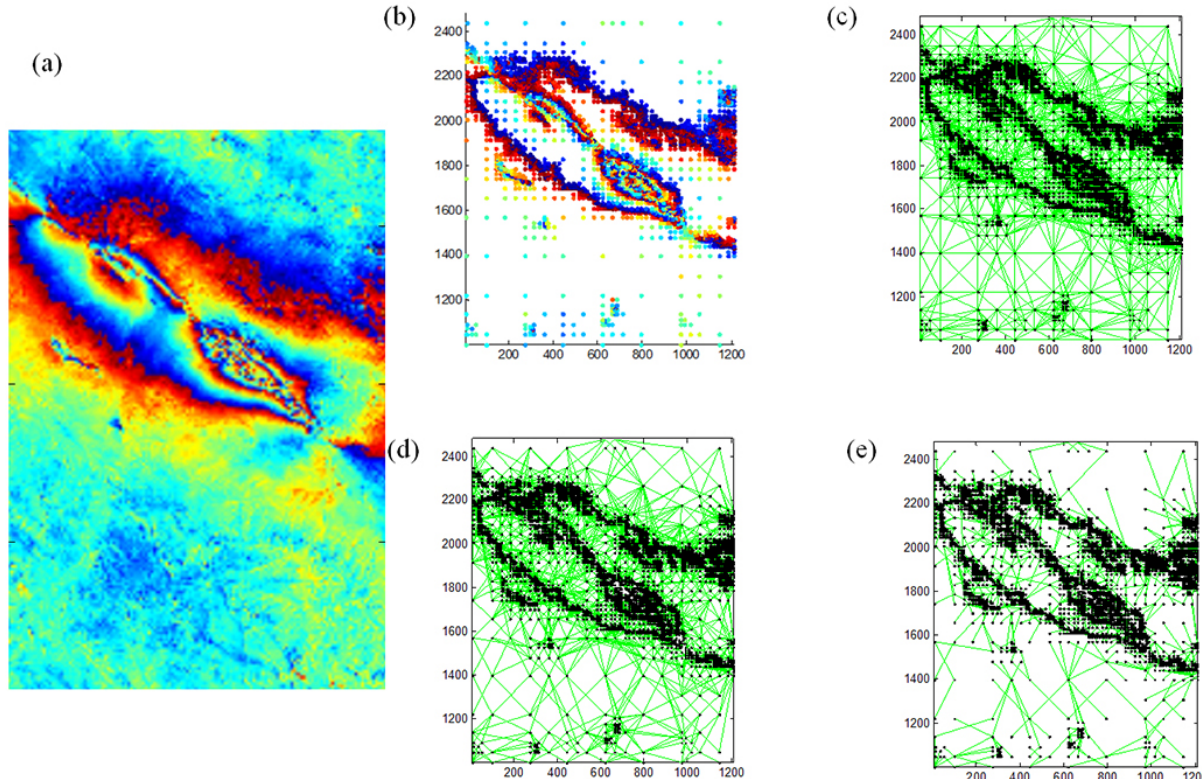
Fig. 4. (a) ALOS PALSAR coseismic deformation interferogram over Yushu. (b) 5173 points after down sampling by using the quadtree algorithm. (c) Local Delaunay triangulation network. (d) Arcs after solving for the phase integer ambiguities. (e) Network after applying the minimum spanning tree